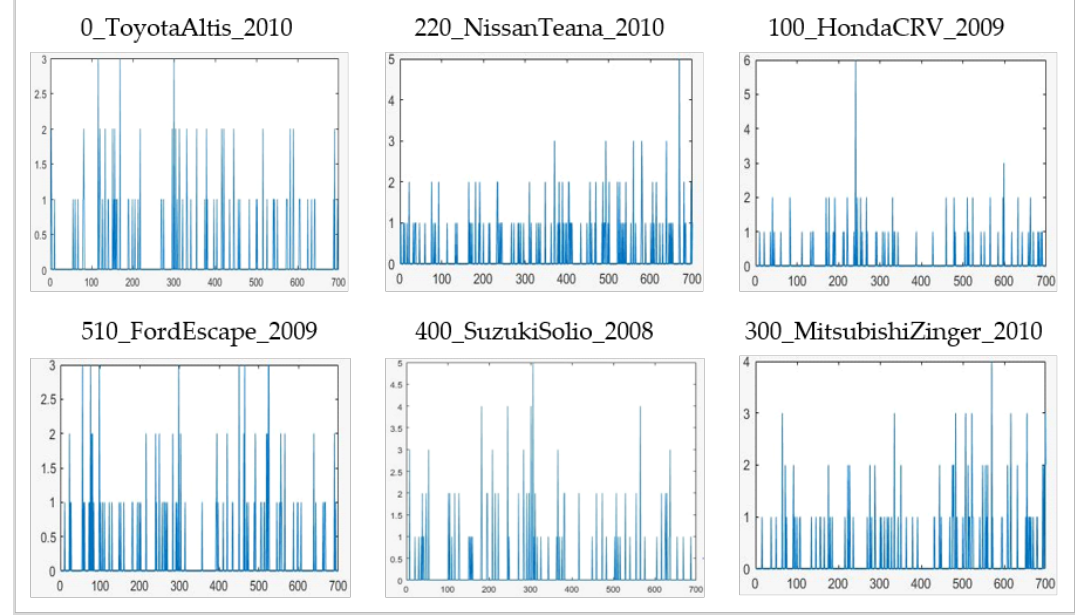
Figure 7. Histograms of expressions for the NTOU-MMR dataset (random sample of each specified vehicle